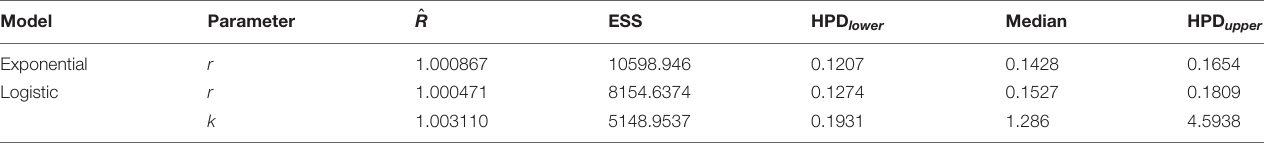
TABLE 1 | Summary of fitted Bayesian